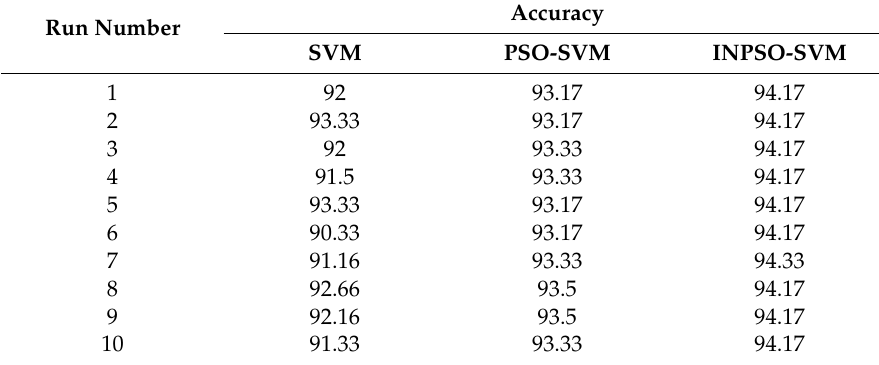
Table 7. The influence of parameter optimization on fault diagnosis accuracy.